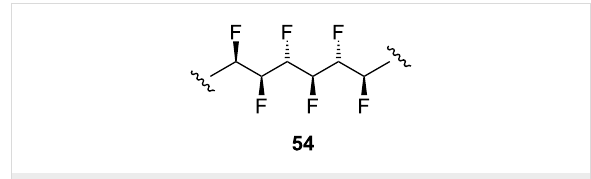
Figure 12: A multi-vicinal